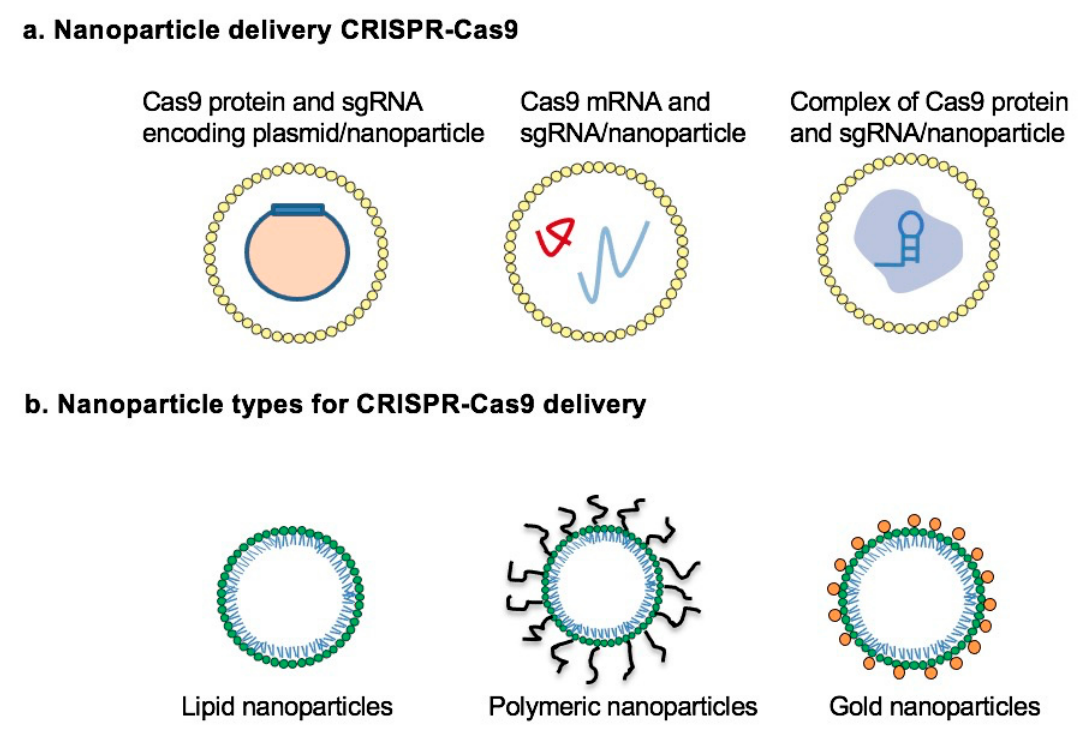
Figure 5. Nanoparticles for drug/gene delivery to combat bacterial infection. ( a ) Nanoparticles enfold different CRISPR- Cas9 delivery forms: Cas9 protein and sgRNA encoding plasmid, Cas9 mRNA and sgRNA, Complex of Cas9 protein and sgRNA. ( b ) Nanoparticles for CRISPR-Cas9 delivery: lipid nanoparticles, polymeric nanoparticles, and gold nanoparticles.